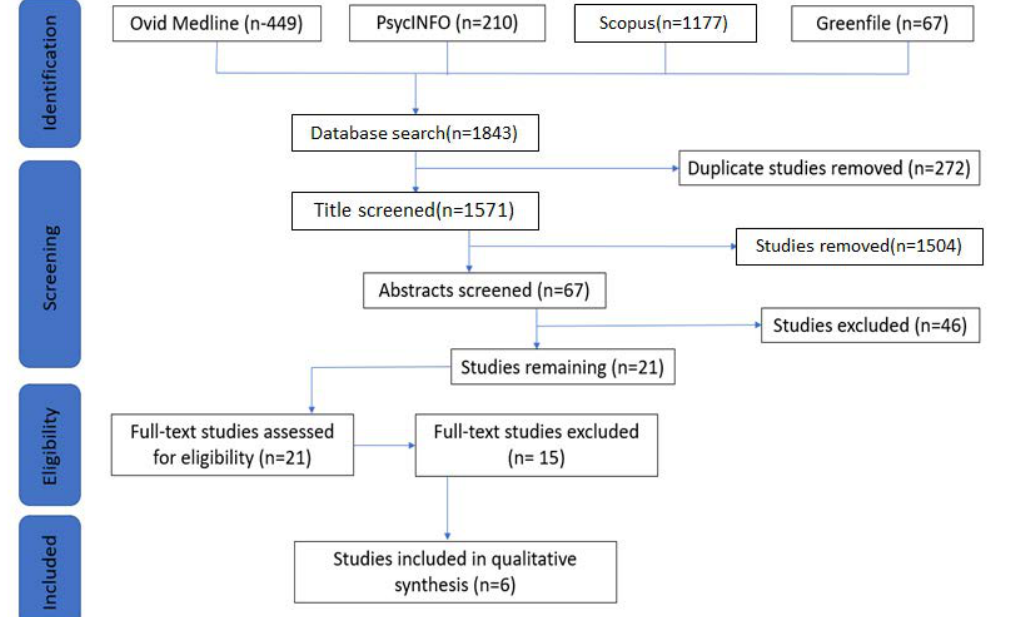
Figure 1. Graphical illustration of PRISMA guidelines in the articles’ selection